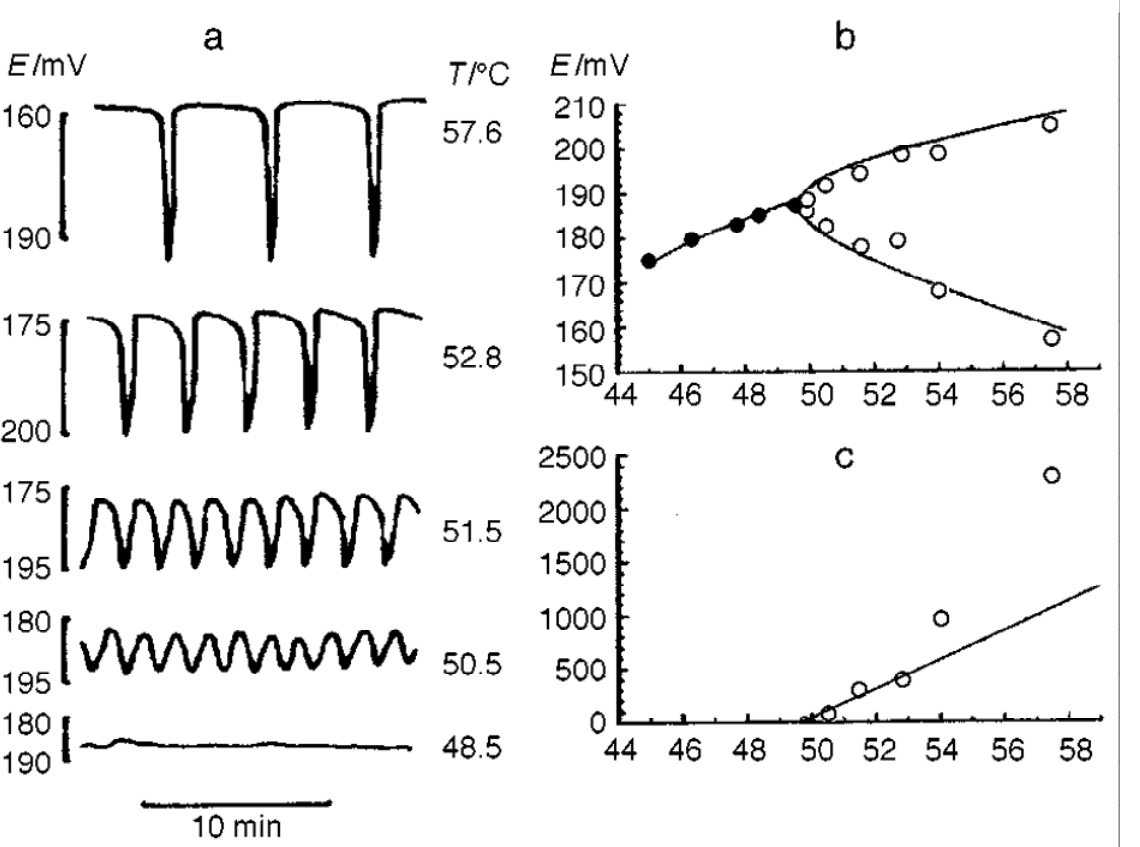
Figure 3. (a) Time series showing stable dynamic structures observed in the BL reaction at different temperatures, under the following experimental conditions: [KIO ] = 5.9×10 -2 M, [H SO ] = 5.5×10 -2 M and [H O ] = 2.0×10 -1 M, specific flow rate j 3 0 2 4 0 2 2 0 rate = 900 rpm. The temperature was controlled within ±0.2 K. (b) Bifurcation diagram showing transition from sustained periodic oscillations (open circles) to a stable stationary state (solid circles) for decreasing temperature. (c) Plot of the square of the oscillation amplitudes (top to bottom) as a function of temperature. (Adapted from